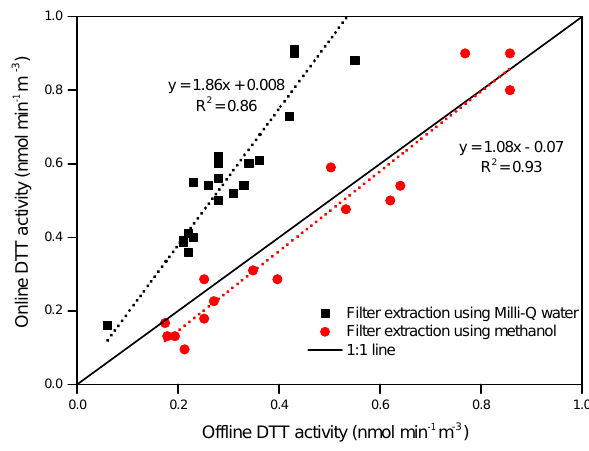
Figure 2. Comparison of the DTT activity obtained from the on- line instrument with the traditional filter collection and extraction methodology (i.e., offline DTT activity analysis of the PM